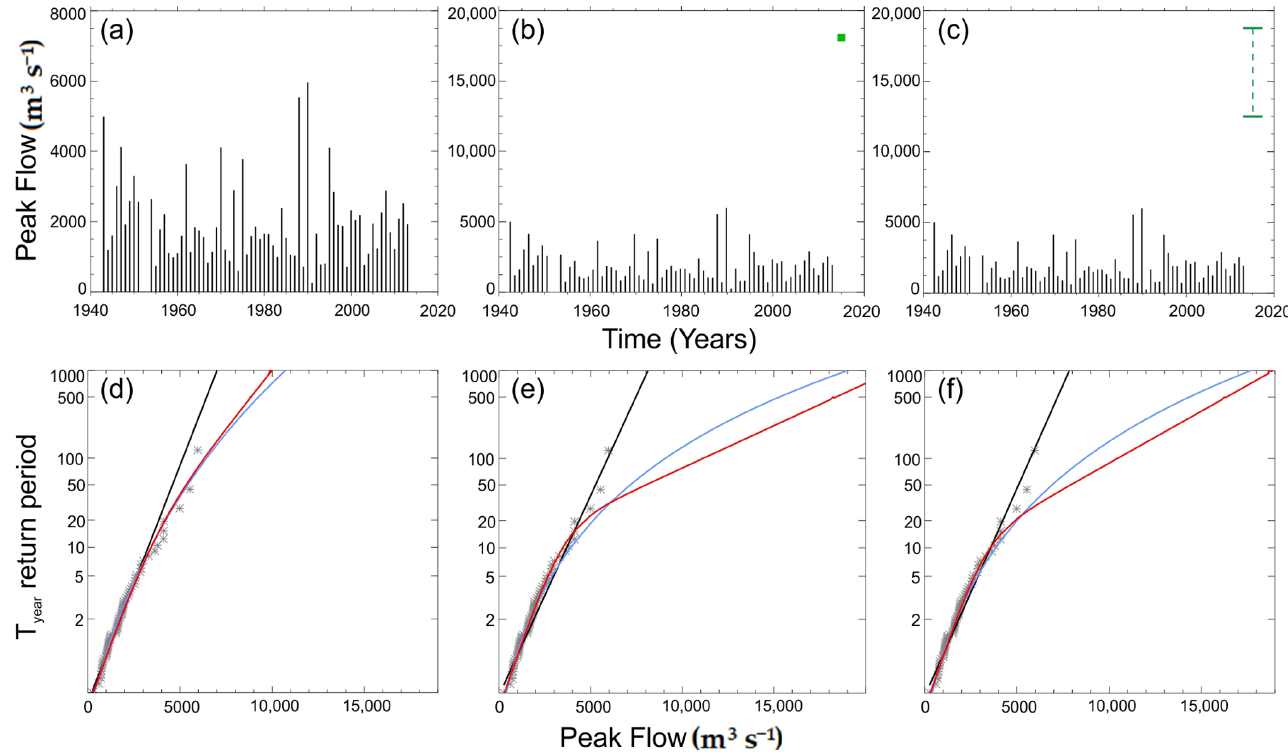
Figure 3. Results for flood frequency analysis (FFAs) in Mocuba city by using only a systematic flow data record ( a , d ), systematic and non-systematic data as censored data ( b , e ), or range data ( c , f ). Peak flow record distribution is shown in ( a – c ). The Gumbel (black line), GEV (blue line) and TCEV (red line) distribution results are shown in ( d – f ). The green dot ( b ) and dashed line ( c ) show the use of non-systematic data related to the January 2015 flooding